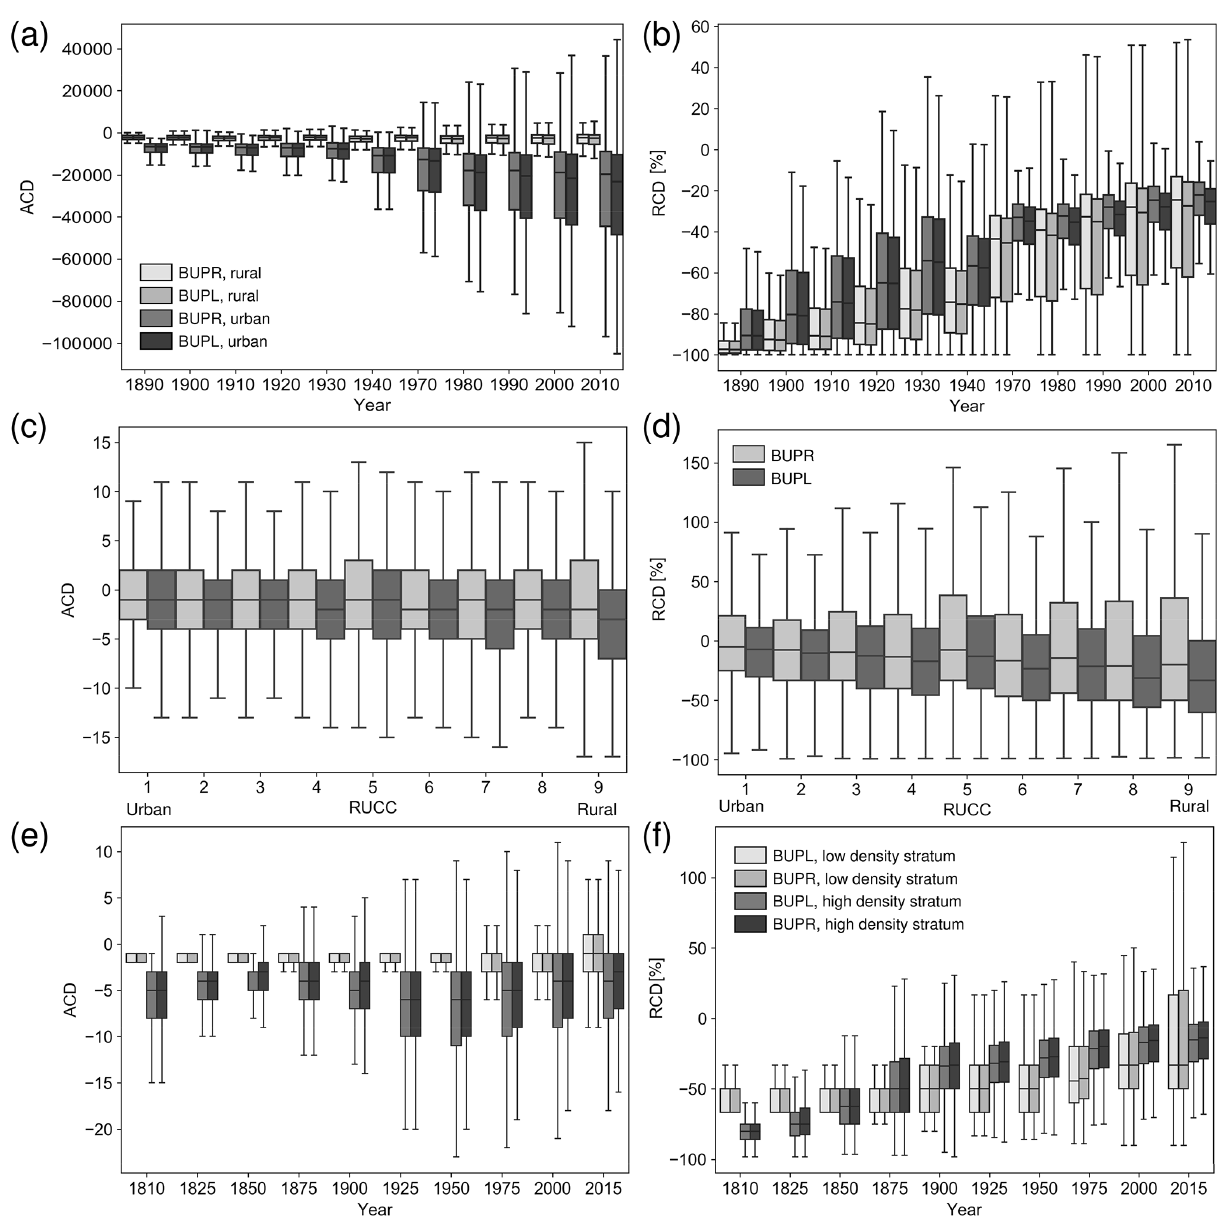
Figure G2. Absolute and relative count differences between BUPR, BUPL, and validation datasets: (a) absolute differences between census housing unit counts and BUPR–BUPL county aggregates over time, calculated within historical county boundaries; (b) corresponding relative differences; (c) grid-cell-level absolute difference distributions against MSBF data across the rural–urban continuum, derived from MSBF- based building density deciles; (d) corresponding relative difference distributions, using reference building density deciles for stratification; (e) temporal trends of grid-cell-level absolute differences against MTBF30; and (f) corresponding relative difference distributions. Urban– rural stratification in (a) , (b) , (e) , and (f) is based on the 75th percentile of reference count distributions per year. Count difference distributions in (e) and (f) are based on 25-year aggregates to achieve sufficiently large sample